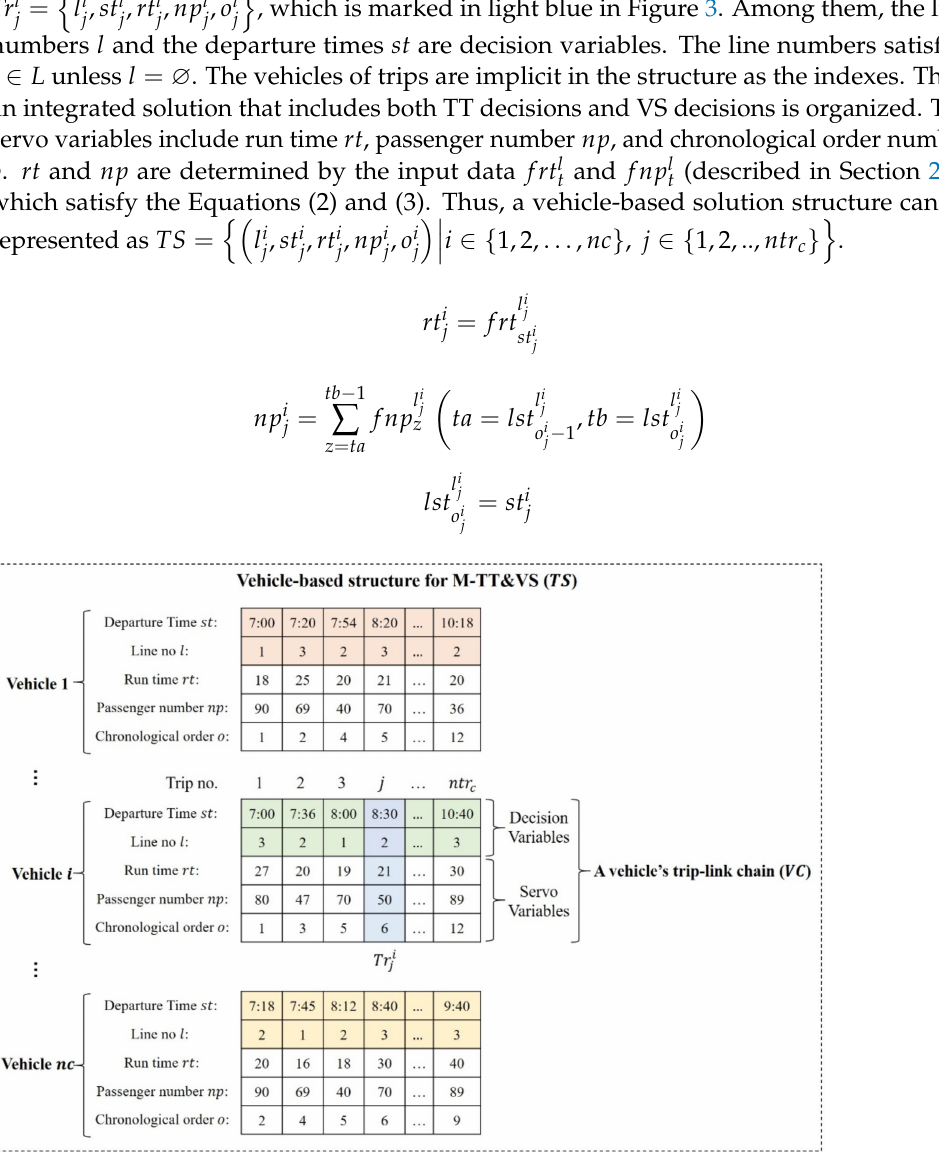
Figure 3. Vehicle-based solution structure for